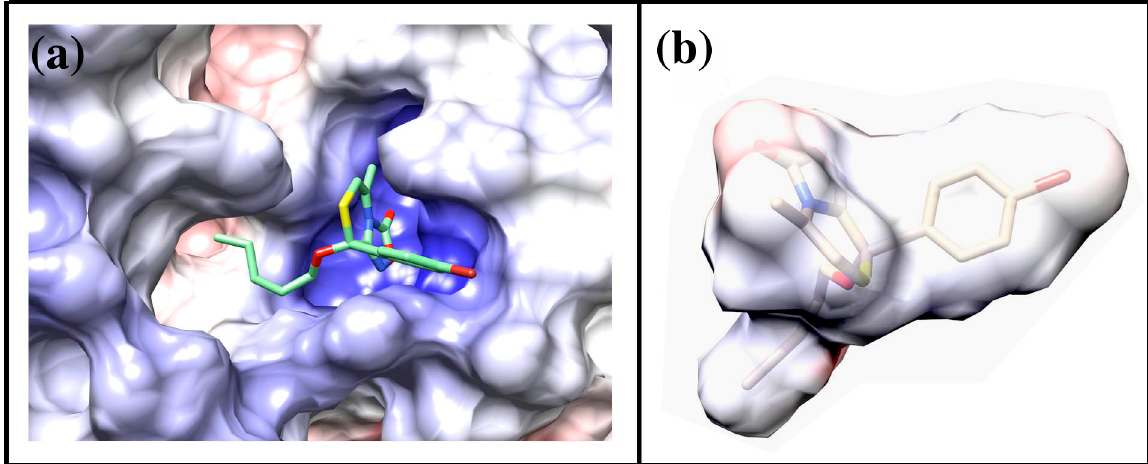
Figure 8. ( a ) Representation of Molecular Electrostatic Potential for the P-glycoprotein and ( b ) compound 27 . In both cases the surface is colored according to its electrostatic potential (blue = positively charged, red = negatively charged). Figure is drawn using the program Chimera [44], electrostatic potential is calculated using the AMBER force field